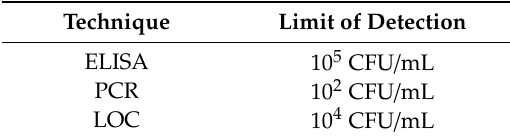
Table 2. Performance comparison: LOC is more e ff ective in detecting P. atrosepticum compared to the ELISA method, while PCR results in higher sensitivity, but at larger